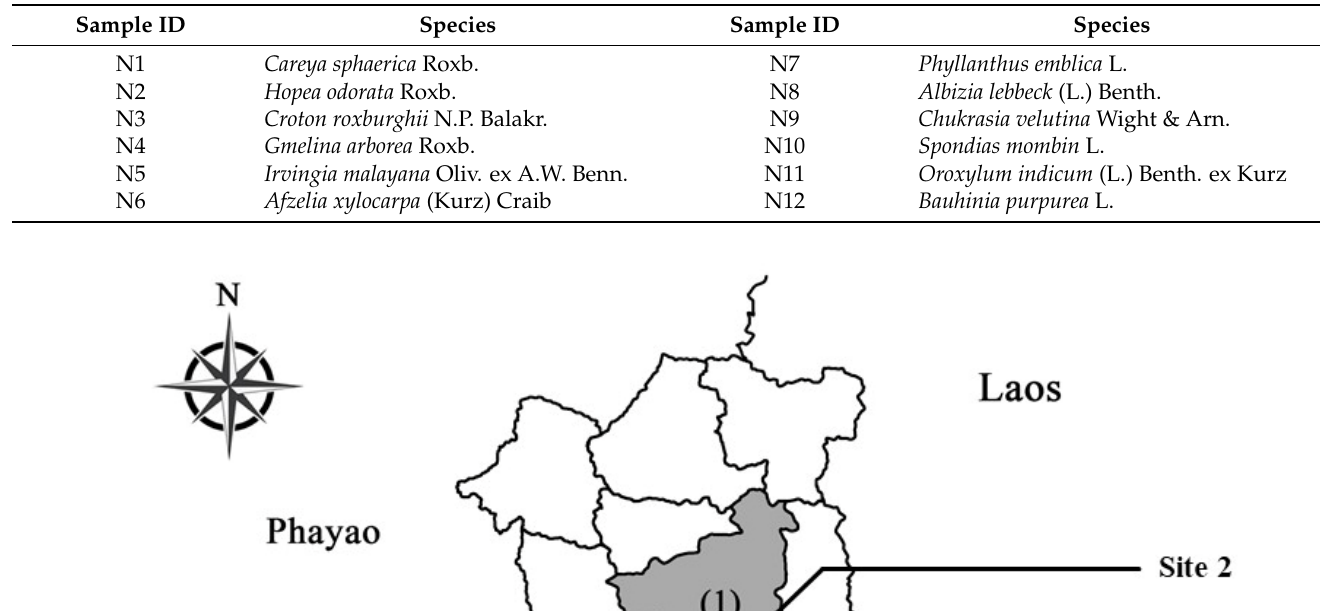
Table 2. DNA concentration of each sample.